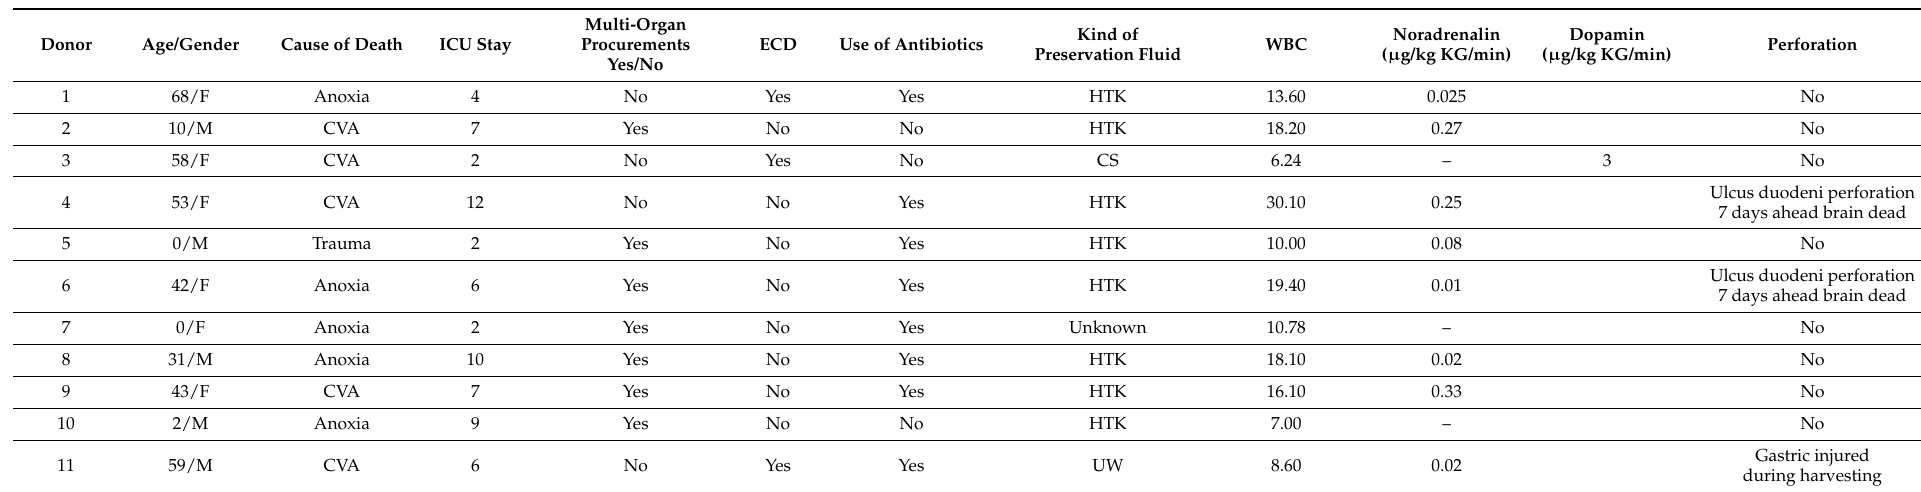
Table 4. Associated donor data of kidney